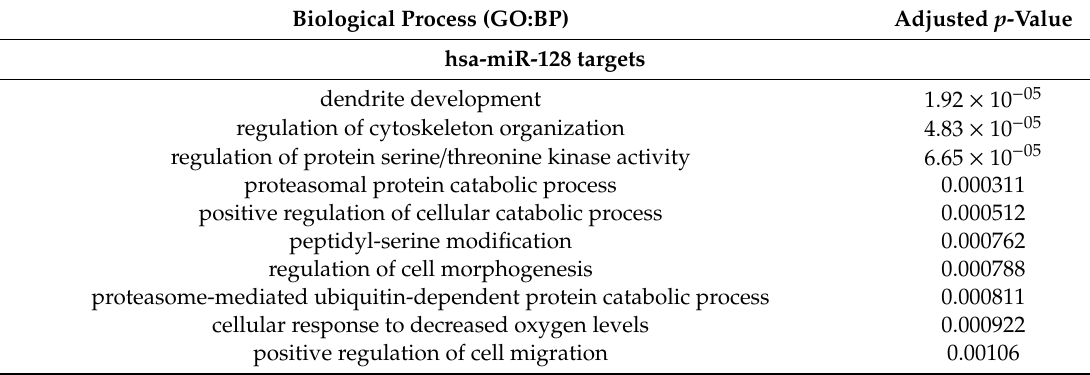
Table 5. Top 10 most enriched biological processes (GO:BP) for the protein-coding gene targets of hsa-miR-128, hsa-miR-155, and their common targets ranked according to an adjusted p -value of